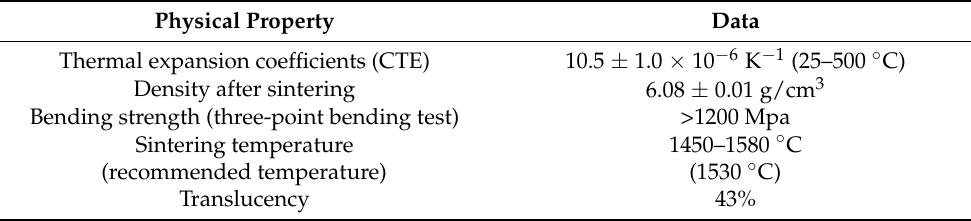
Table 2. Main physical data of the used zirconia.